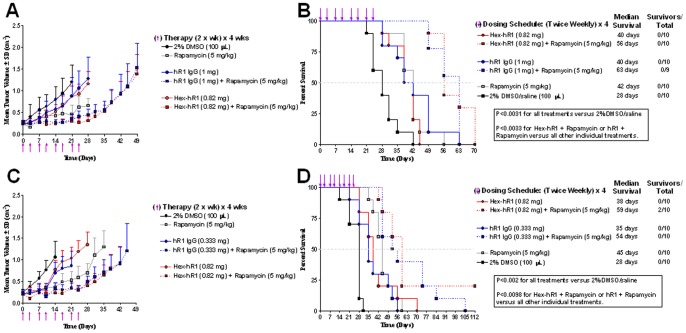
Anti-tumor activity in vivo.Mice bearing sc RH-30 tumors were administered with 100 µL 2% DMSO as control, 5 mg/kg Rapamycin, hR1-IgG and Hex-hR1 with or without Rapamycin twice weekly for 4 weeks. Tumor growth (A, C) and survival (B, D) were shown for the equimolar Fab (A and B) and protein doses (C and D).